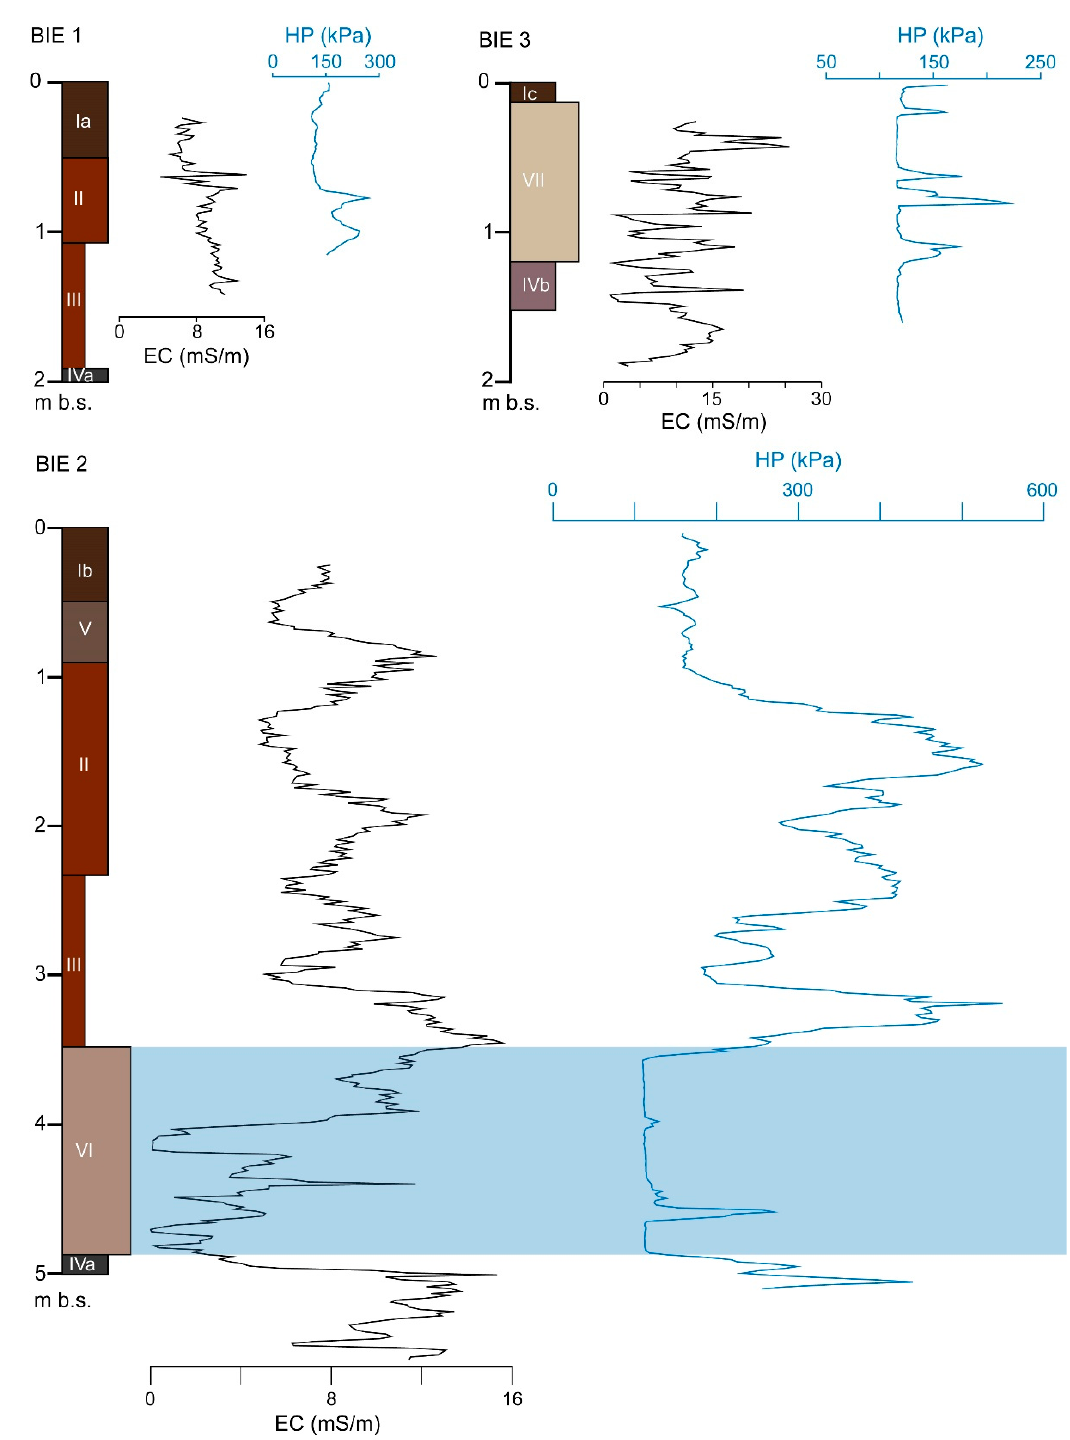
Figure 7. Sediment cores BIE 1 to 3 with DP HPT data (electrical conductivity, EC and hydraulic pressure (HP). Sediment units Ia–VII refer to description in Table 3 (see also Figure 5). Table 3. Sediment units described for the Biersdorf sediment cores.